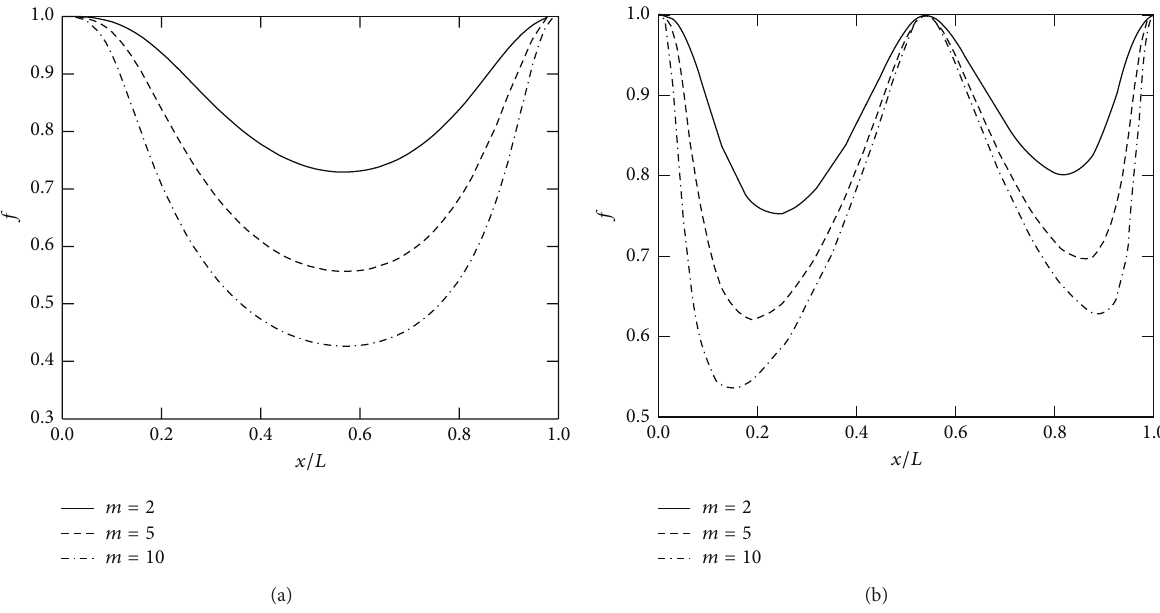
Figure 9: The first two normalized natural frequencies of clamped-simple Timoshenko beam subjected to a moving mass with different masses.